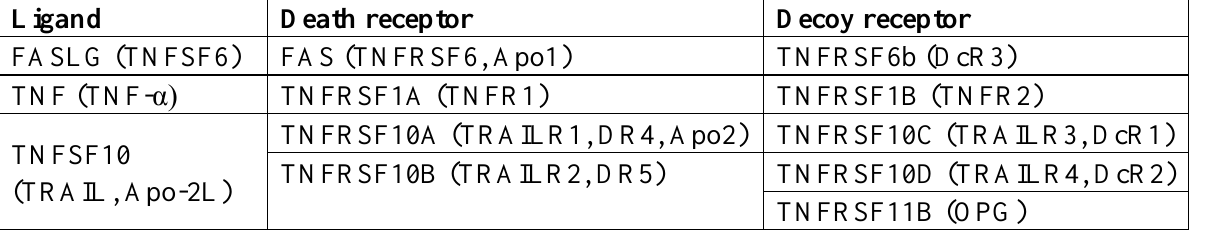
Table 1. Compendium of the death receptors with their adequate ligands and decoy receptors. The terms in parentheses are the genes’